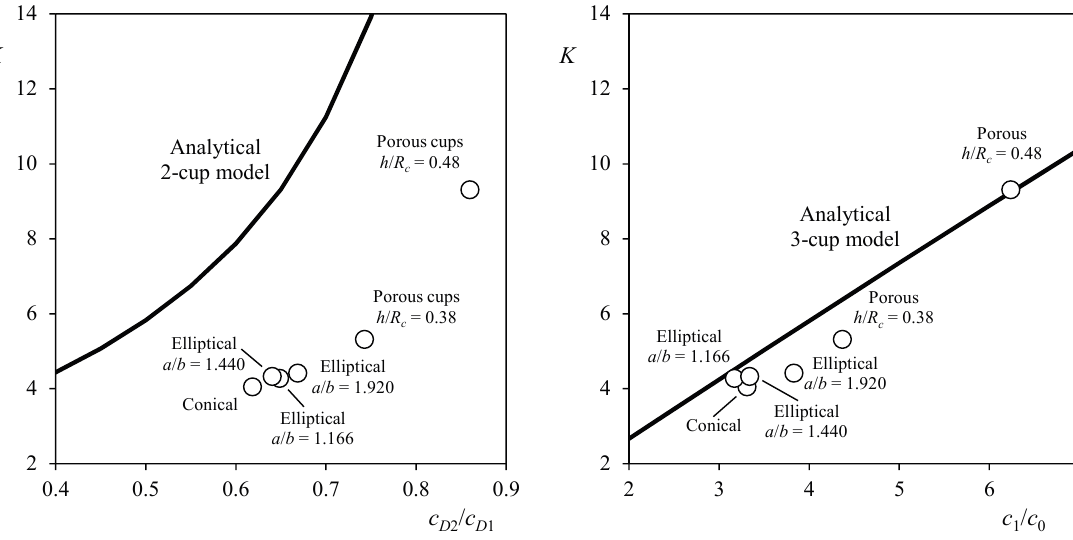
Figure 6. Comparison between results obtained with 2-cup ( Left ) and 3-cup ( Right ) analytical models and testing results. The anemometer factor is expressed as a function of the coefficients ratio c D 1 / c D 2 (2-cup model) and c 1 / c 0 (3-cup model). The experimental results correspond to calibrations performed on an Ornytion 107A anemometer equipped with different cup rotors. The cups shapes are sketched in Figure